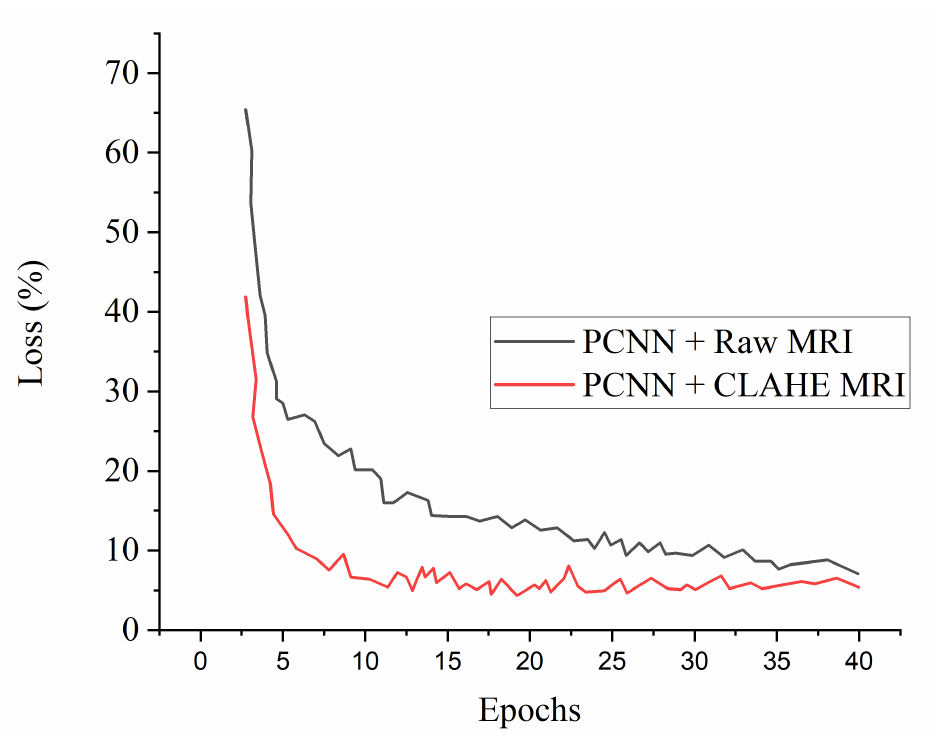
Figure 6. Loss curves for the proposed PCNN in comparison with raw MRI and CLAHE pre- processed MRI images.